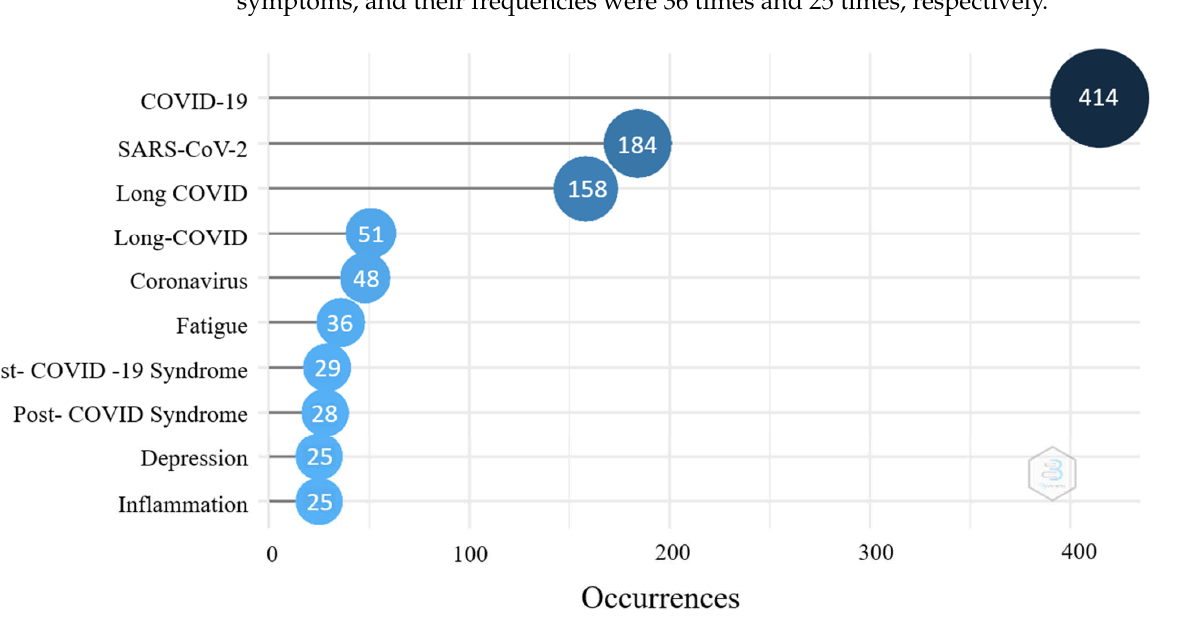
Figure 5. Top ten most frequent keywords.